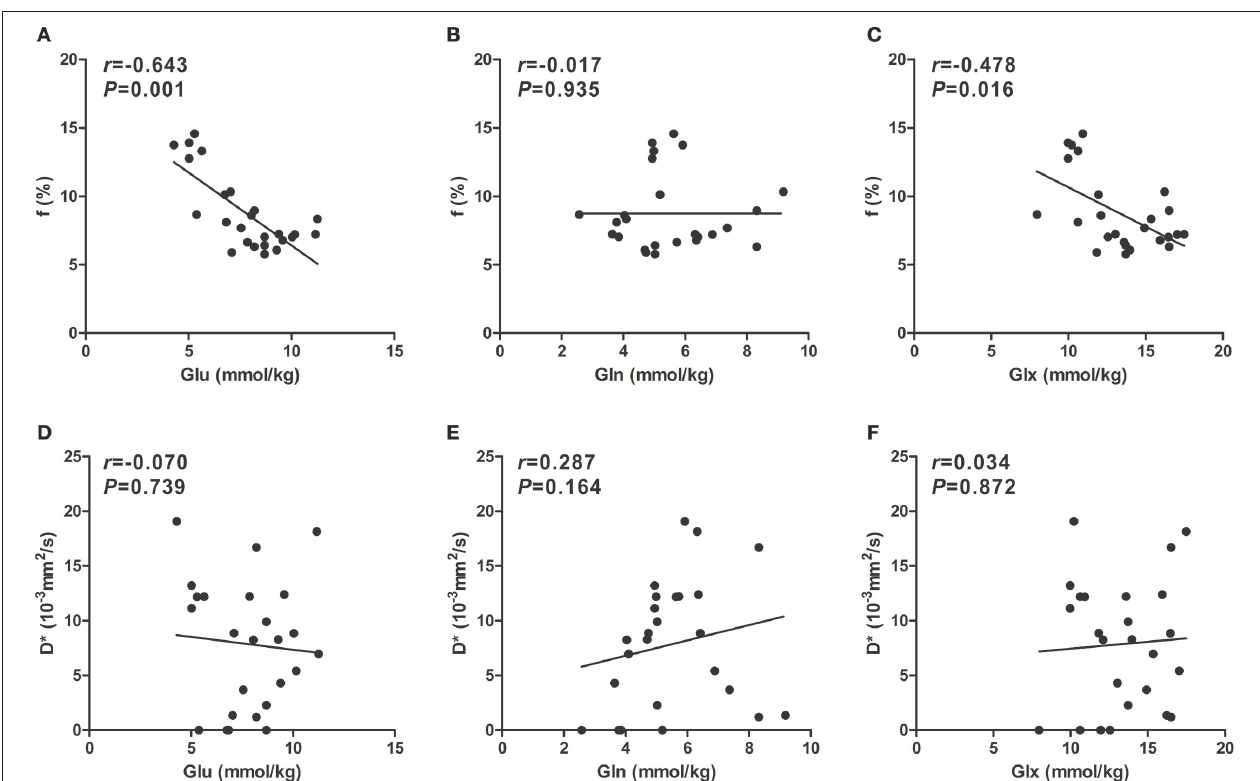
FIGURE 6 | Scatter plots of IVIM-derived f (%) and D * ( × 10 − 3 mm 2 /s) parameters over concentrations (mmol/kg) of Glu, Gln, and Glx. A significant negative correlation between f values and the Glu concentration was observed (A) , whereas an ordinary negative correlation between f values and the Glx concentration was observed (C) . However, there was no correlation between f values and the Gln concentration (B) . Unlike for f values, no correlation between D * values and Glu (D) , Gln (E) , or Glx (F) concentrations was observed. Spearman’s rank correlation coefficient r was calculated. Glu, glutamate; Gln, glutamine; Glx, glutamate +